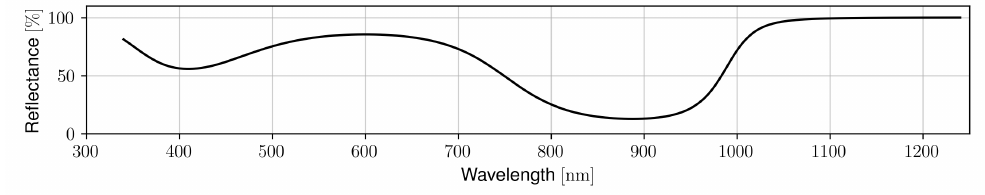
Figure 12. Spectral reflectance of LCS 1 estimated from spectral upsampling based on the albedo values in Table